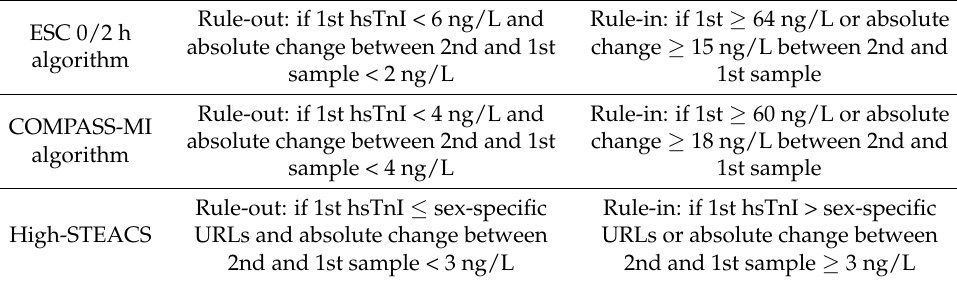
Table 1. Algorithms used for rule-out and rule-in with hsTnI